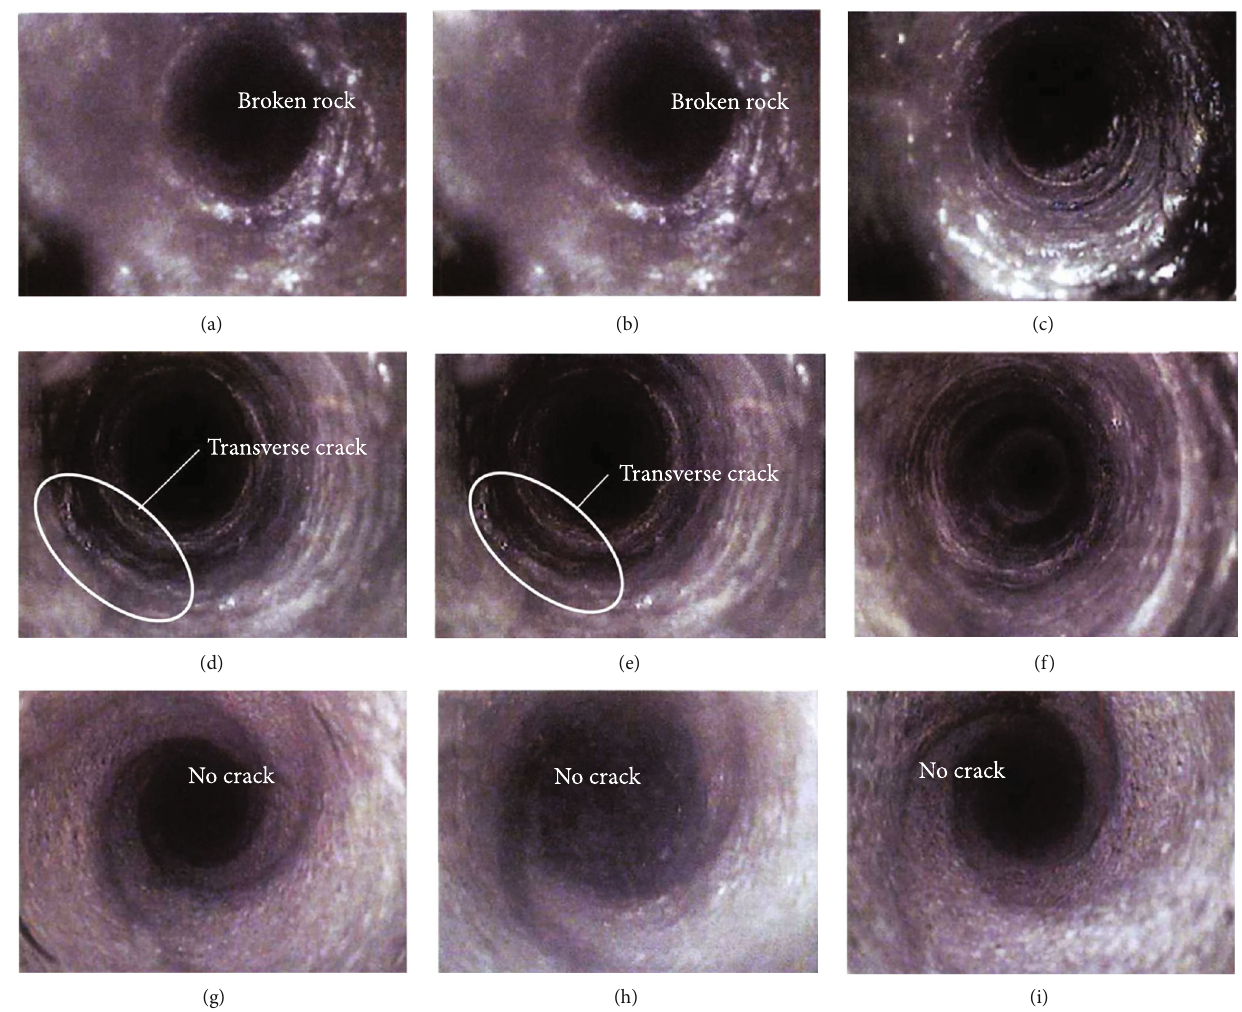
Figure 13: Borehole peeping results ((a) – (c) borehole depth is 10 m; (d) – (f) borehole depth is 20 m; (g) – (i) borehole depth is